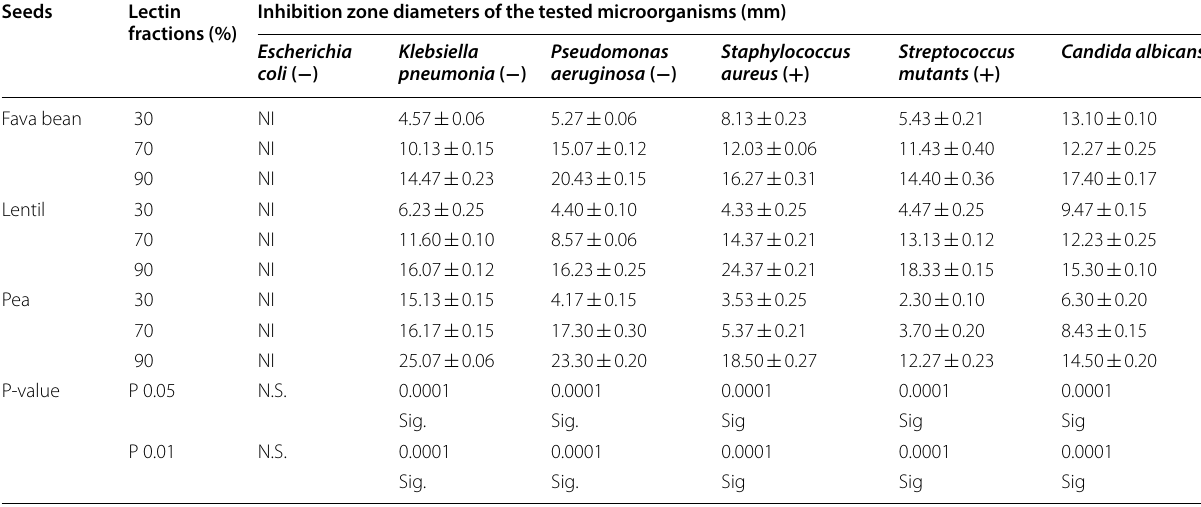
Antimicrobial activity measured as inhibition zones diameters (mm) The results are represented as mean of three replicates with